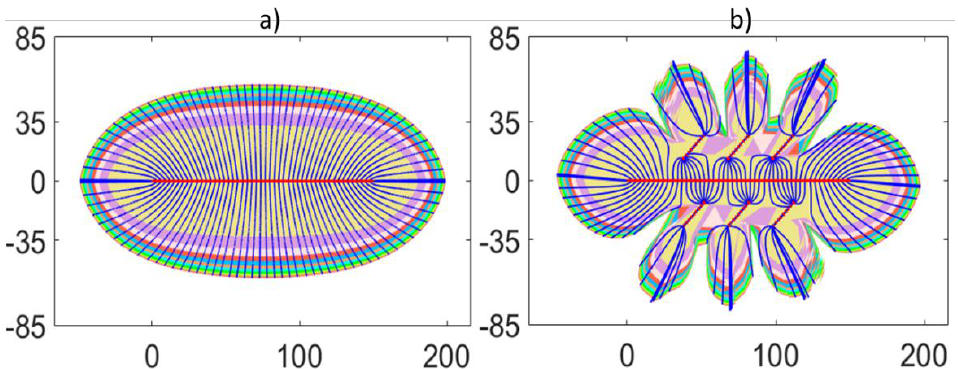
Figure 11. ( a ) DRV around a single hydraulic fracture with no natural fractures around, ( b ) DRV around a single hydraulic fracture with 6 natural fractures with porosity of 8.4% and corresponding strength of 155 ft 4 /day from CK correlation after 30 years production. Hydraulic fracture in red, Streamlines in blue, Natural fractures in dashed red lines. Rainbow colored fill shows drained areas after 3-year time periods.